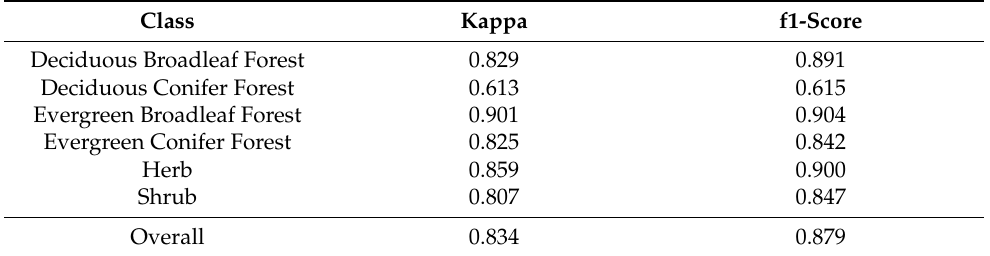
Table 3. Class-wise performance of the physiognomy level classification of plant communities.